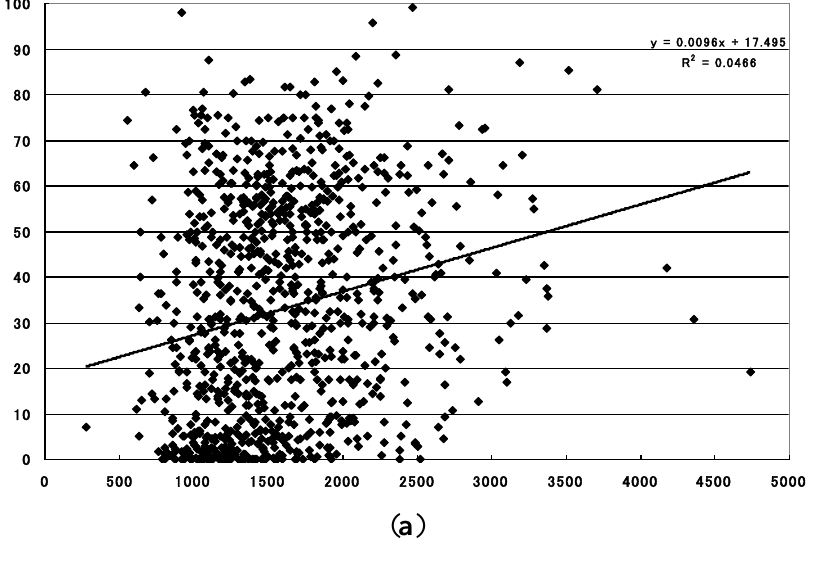
Figure 2. Relationship between annual precipitation and sero-conversion rate to JE virus in sentinel pigs in the whole of Japan. ( a ) Statistically significant positive relationship with the mean sero-conversion rate ( p = 1.899 × 10 −11 ). X-axis: precipitation during the period (mm), Y-axis: sero-conversion rate to JE virus (%); ( b ) Statistically significant positive relationship with the maximum sero-conversion rate ( p = 7.790 × 10 −13 ). X-axis: precipitation during the period (mm), Y-axis: sero-conversion rate to JE virus (%). y = 0.0096x + 17.495 R 2 =